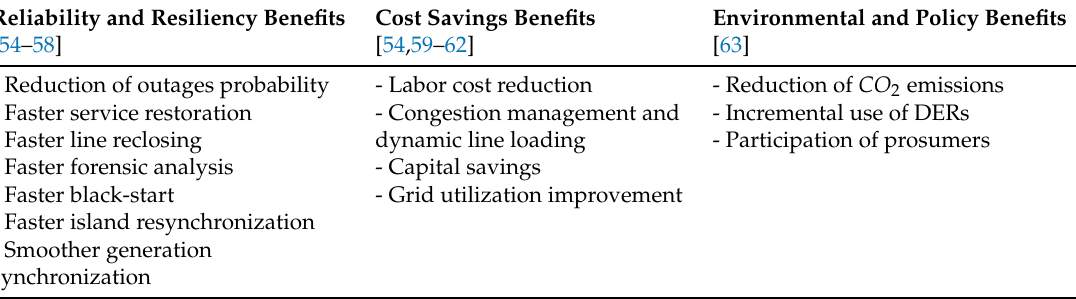
Table 5. Benefits of using µ PMU data in the distribution